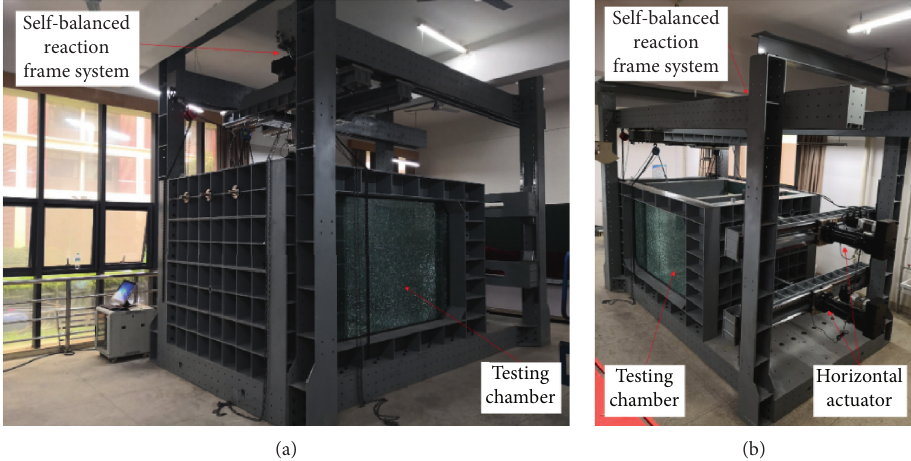
Figure 10: The quasistatic testing device assembled on the ground. (a) View from passive side. (b) View from push